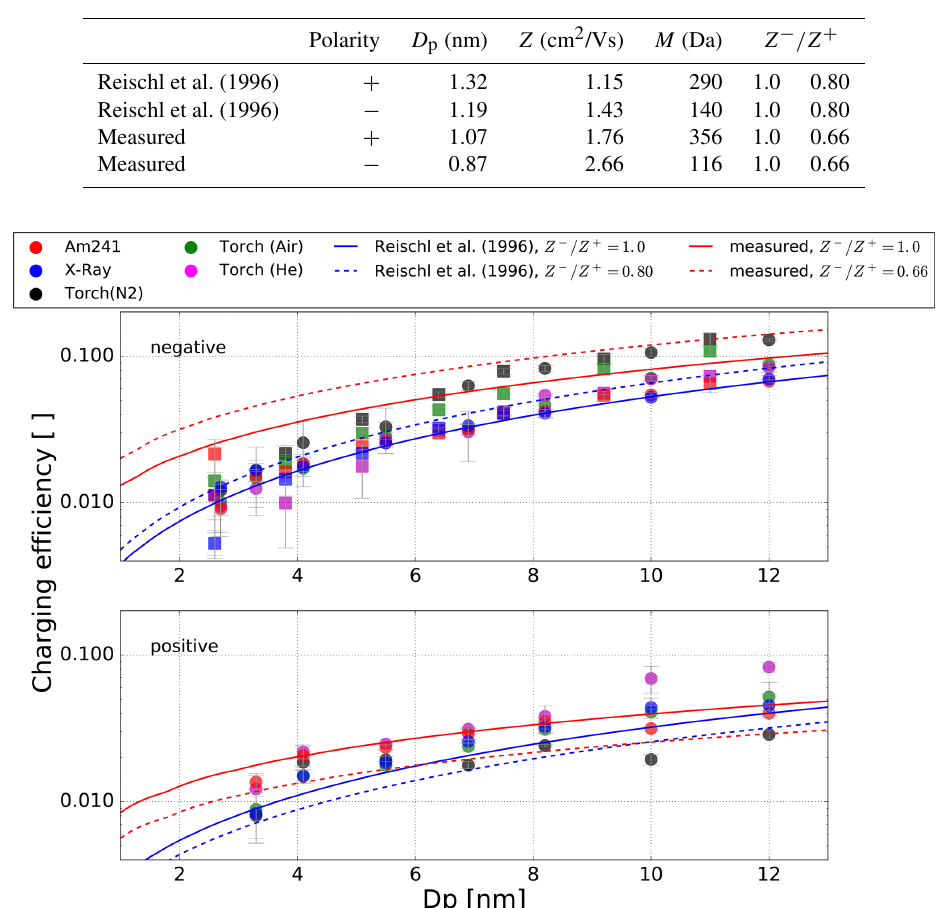
Table 4. Comparison of ion cluster properties: polarity, mobility diameter D p calculated from mean ion mobility Z , mean ion mass M and ion mobility ratio Z − /Z + .